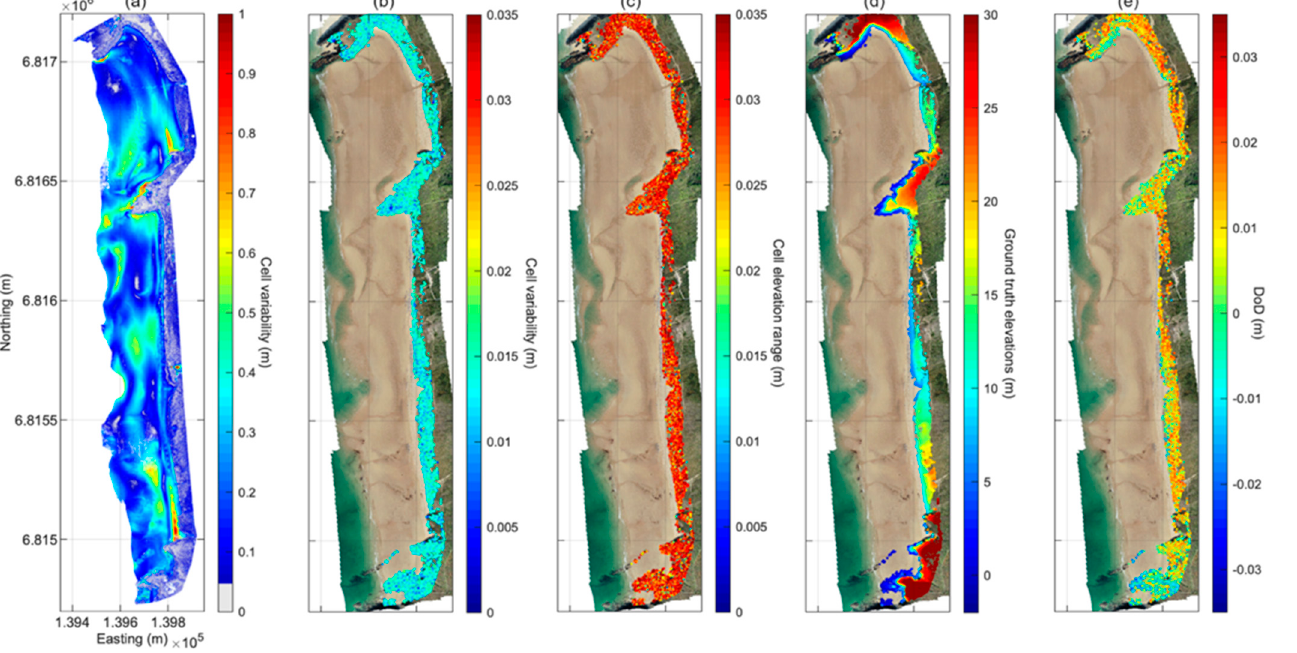
Figure 7. Assessment of photogrammetric workflow replicability at La Palue. ( a ) Cell variability using all repeat surveys ( n = 4); ( b ) cell variability and ( c ) cell elevation range after thresholding to retain only supposedly stable cells ( n = 587,105 cells); ( d ) resulting ground truth elevations over stable cells and ( e ) comparison of 17 September 2020 survey with the ground truth.